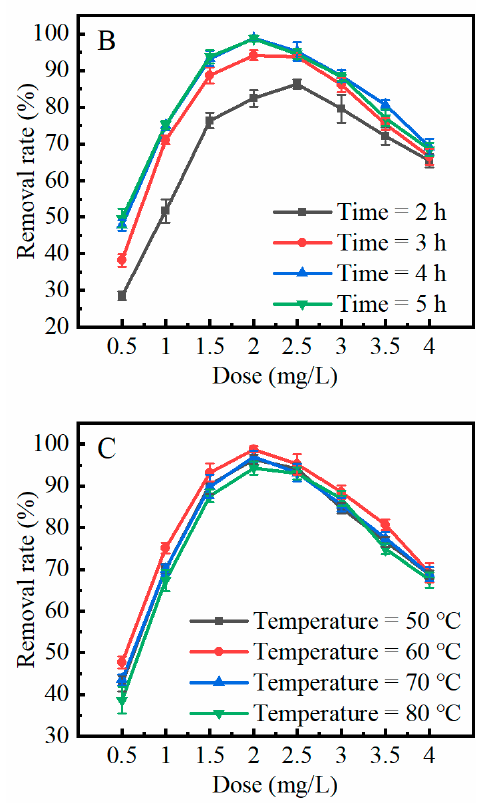
Figure 2. Effect of production conditions on removal rate of lignin-based flocculant: ( A ) impregnation ratio, ( B ) time, and ( C ) temperature. Error bars represent the standard deviation from three repetitions.